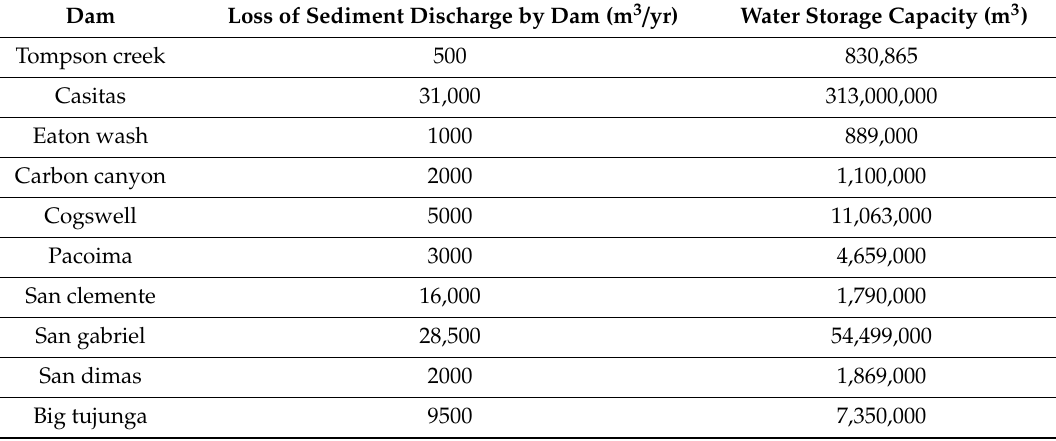
Table 2. Water storage capacity and sediment discharge behind each dam